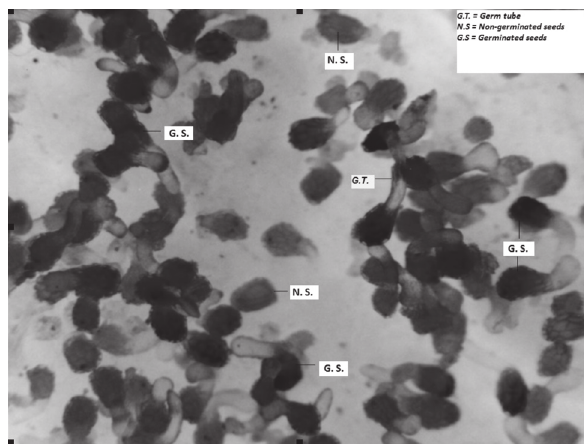
Figure 1. Microscopic view showing germinated Orobanche ramosa seeds with well developed protruding germ